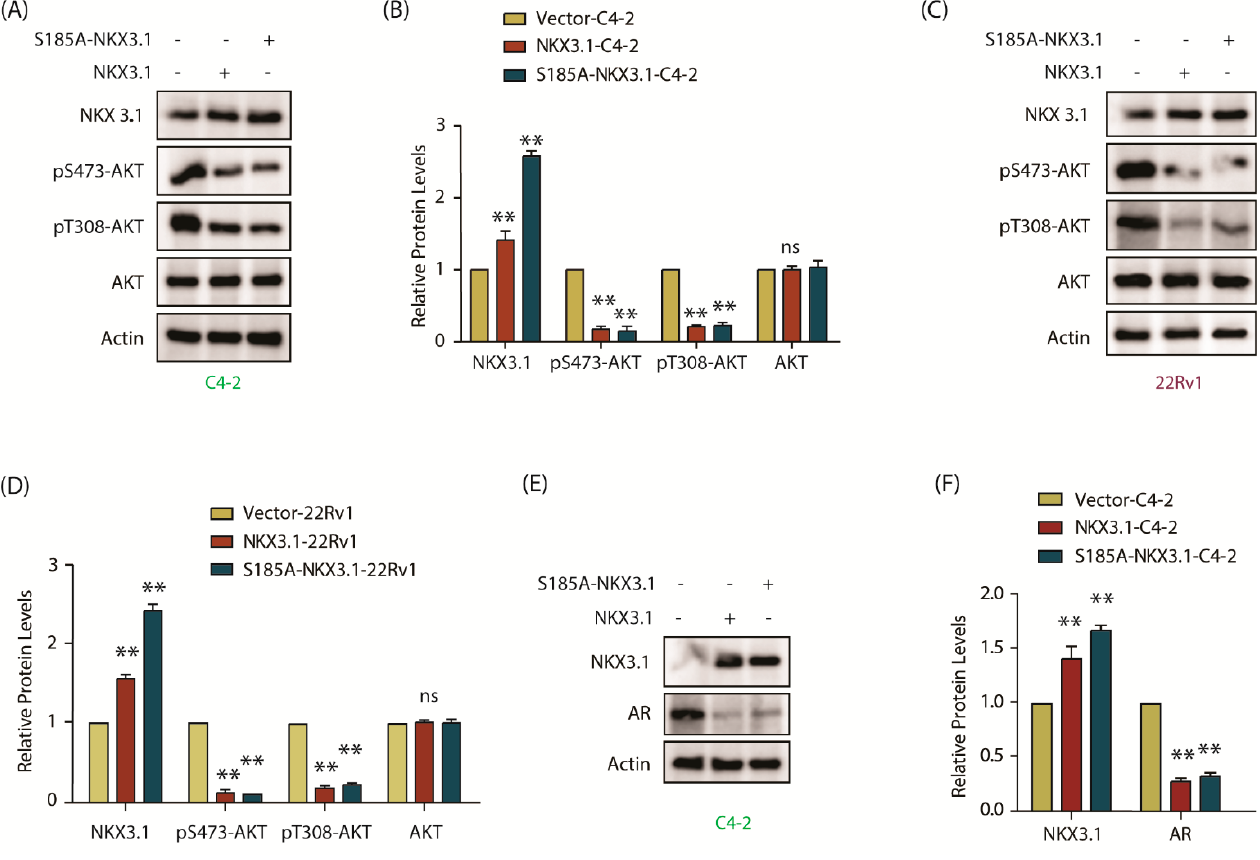
Figure 7. NKX 3.1 inhibits AKT phosphorylation, and depletes AR and ARv7. ( A ) Levels of phospho-AKT in NKX3.1- and S185A-NKX3.1-overexpressing C4-2 cells are much lower than vector-expressing control cells. Control, NKX3.1-C4-2, and S185A-NKX3.1-C4-2 cells were assayed for p-AKT levels along with AKT and actin; ( B ) The histogram shows changes in AKT phosphorylation levels in response to NKX3.1 and S185A-NKX3.1 expression. The data obtained from three inde- pendent experiments were normalized against actin and represented as mean ±SEM [ ** p <0.01, ns = not significant]; ( C ) The extent of AKT phosphorylation is lowered by ectopic overexpression of wild-type and phospho-resistant NKX3.1 in 22Rv1 cells. p-AKT and AKT levels in vector control, NKX3.1-22Rv1, and S185A-NKX3.1-22Rv1 cells were monitored